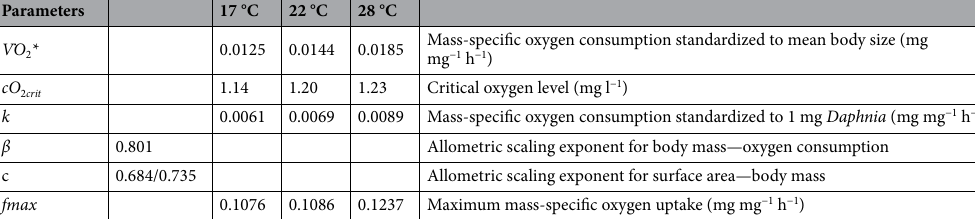
Table 1. Estimated parameters from Daphnia magna respiration experiment used to predict the strength of the temperature-size relationship. For temperature-dependent parameters, separate values are given for measurements conducted at different